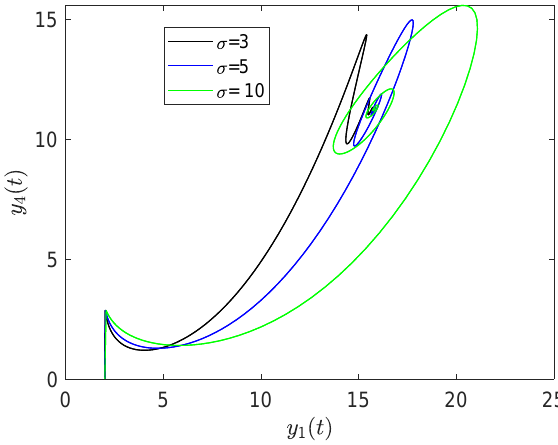
Figure 52. Phase portraits of y 1 and y 4 when varying σ .